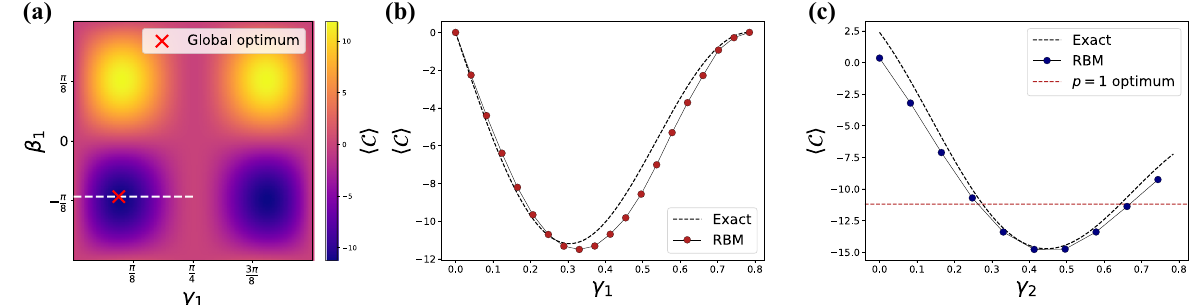
Fig. 2 Benchmarking the cost function for 20 qubits. a The exact variational QAOA landscape at p = 1 of a random 20-qubit instance of a 3- regular graph is presented, calculated using the analytical cost formula (see Supplementary Note 1). The optimum is found using a gradient- based optimizer 43 and marked. The restricted cut along the constant- β line and at optimal γ is more closely studied in panel b . b RBM-based output wavefunctions are contrasted with exact results. c A similar variational landscape cut is presented at p = 2. Optimal p = 2 QAOA parameters are calculated using numerical derivatives and a gradient-based optimizer. Parameters γ 1 , β 1 , and β 2 are fi xed at their optimal values while the cost function γ 2 -dependence is investigated. We note that our approach is able to accurately reproduce the increased proximity to the combinatorial optimum associated with increasing QAOA depth p . (The dashed line represents the minumum from p = 1 curve in panel b .).